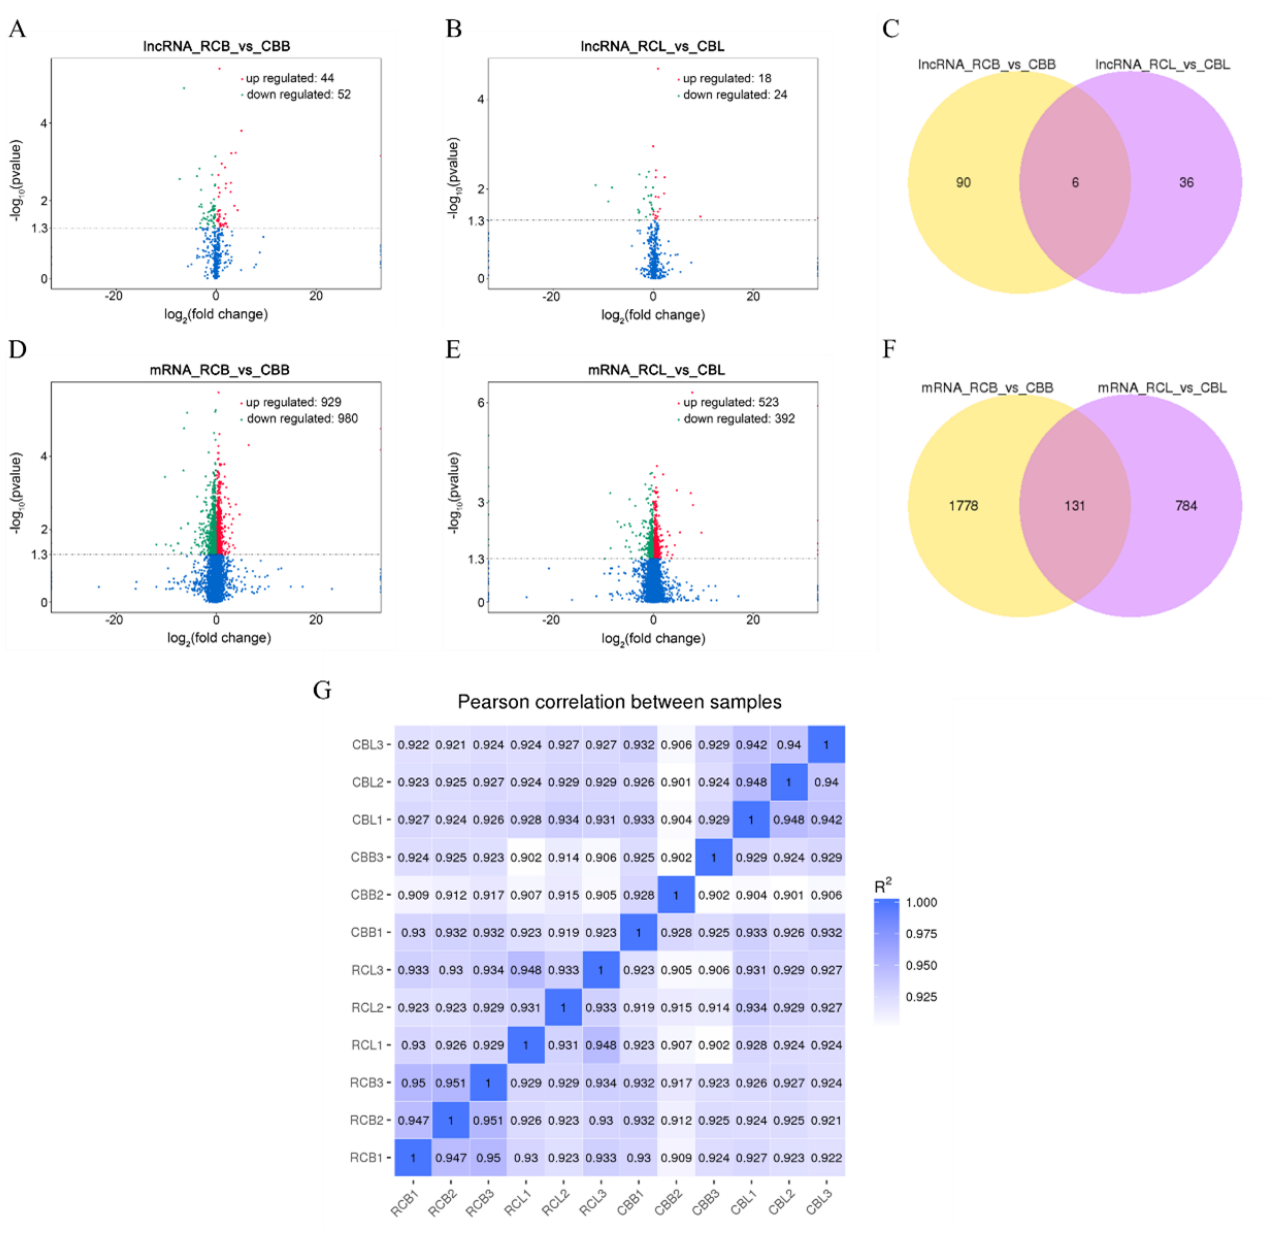
Figure 3. Analysis of differentially expressed lncRNAs and mRNAs. (A), (B), (D), and (E) Volcano plots of differentially expressed lncRNAs and mR - NAs from two comparisons (RCB vs CBB and RCL vs CBL). (C) and (F) Venn diagram of differentially expressed lncRNAs and mRNAs from two comparisons (RCB vs CBB and RCL vs CBL). (G) Correlation map between all samples. The color range from blue to white indicates high to low correlations (RCB, rose-crown chicken breast muscles; CBB, Cobb broiler chicken breast muscles; RCL, rose-crown chicken leg muscles; CBL, Cobb broiler chicken leg